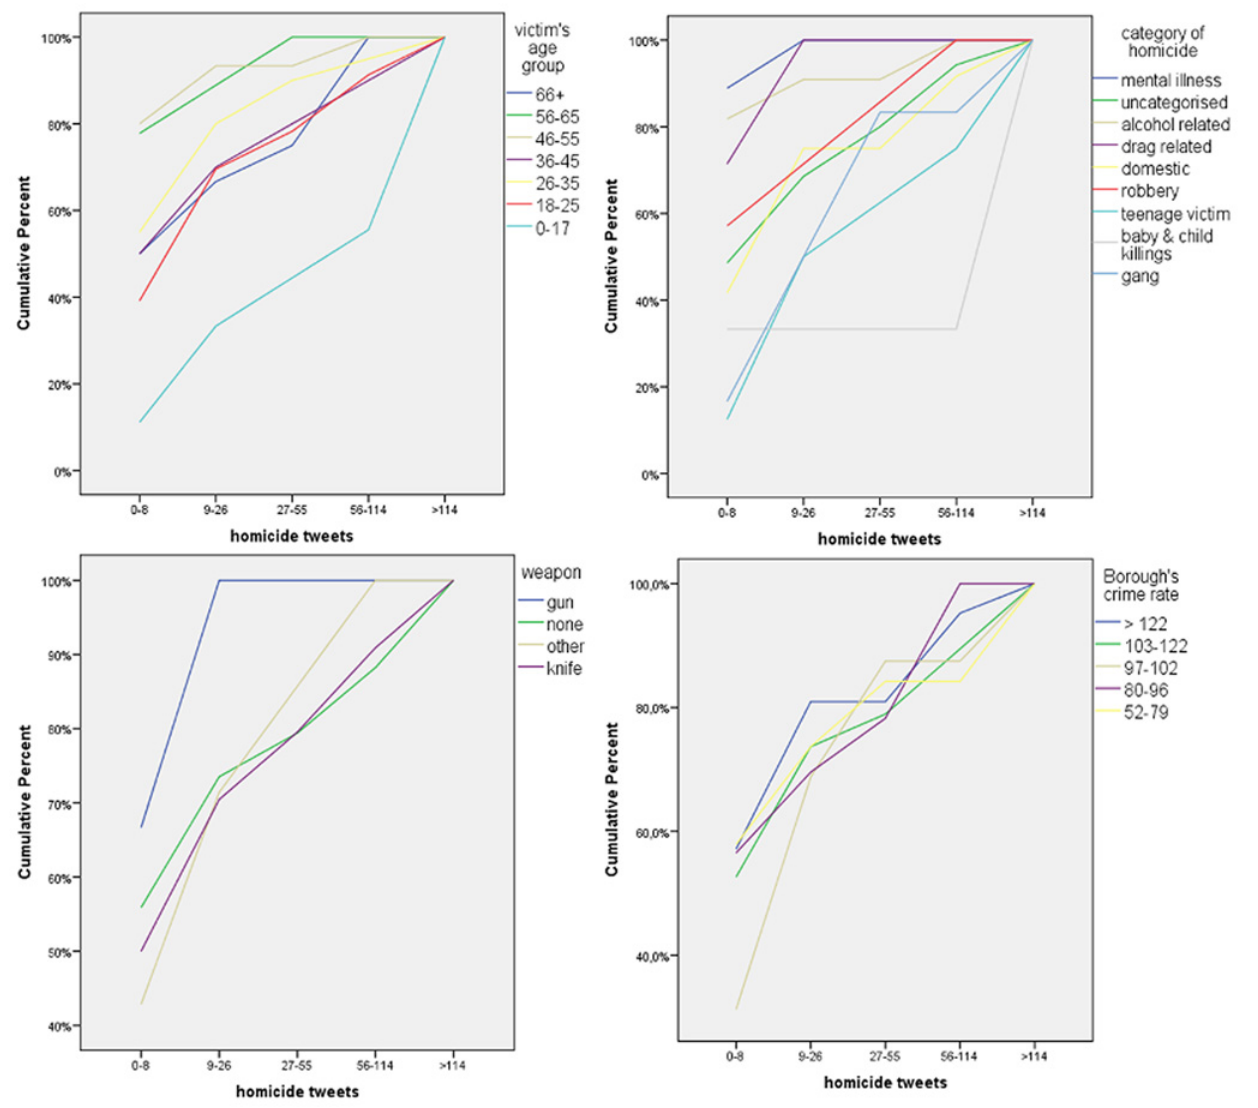
Fig 7. Cumulative percentages of the tweets ’ frequency by categories of each